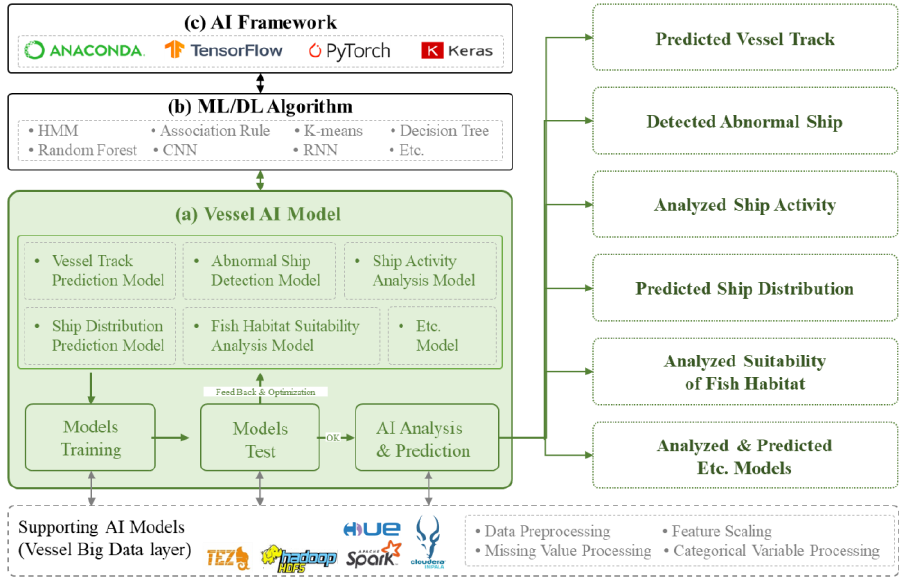
Figure 8. Conceptual Diagram of Vessel AI layer. ( a ) Vessel AI Model; ( b ) ML/DL Algorithm; ( c ) AI